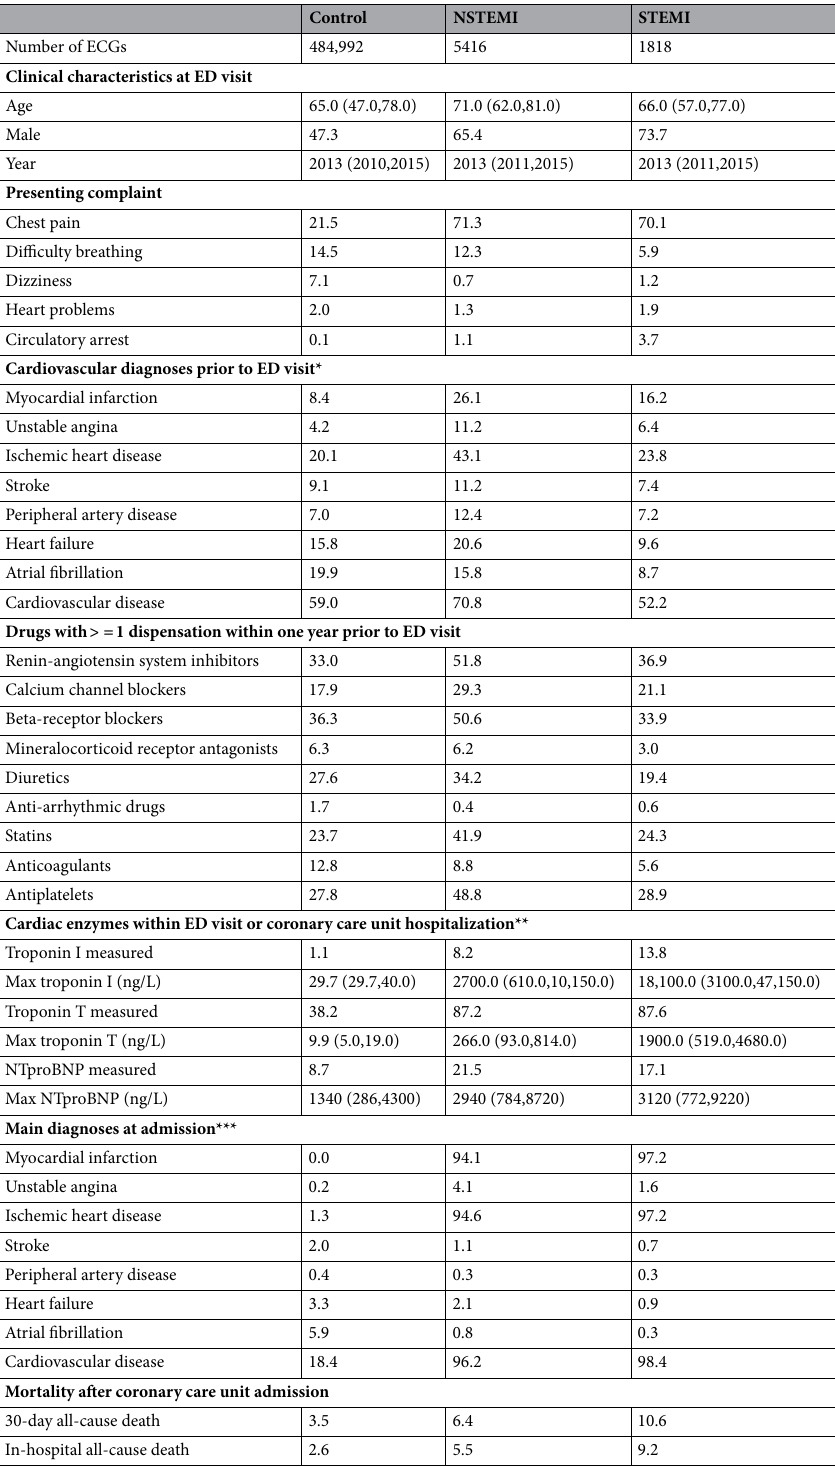
Table 1. Clinical characteristics of the study sample. Patient characteristics of coronary care unit admissions included in the study, by control/NSTEMI/STEMI outcome. Data are medians (quartiles) or percent. *Prevalent disease based on any diagnosis position, inpatient and outpatient specialist care combined. **Combining troponin and high-sensitive troponin laboratory measurements from regional laboratory databases and the SWEDEHEART database. Maximum of all available measurements within the time window reported. Done separately for troponin I and T. ***Primary diagnosis from inpatient specialist care and/or specialized outpatient care at time of the ED/CCU visit. STEMI, ST-elevation myocardial infarction; NSTEMI, non-ST-elevation myocardial infarction; ED, emergency department; NTproBNP, N-terminal pro-B-type natriuretic